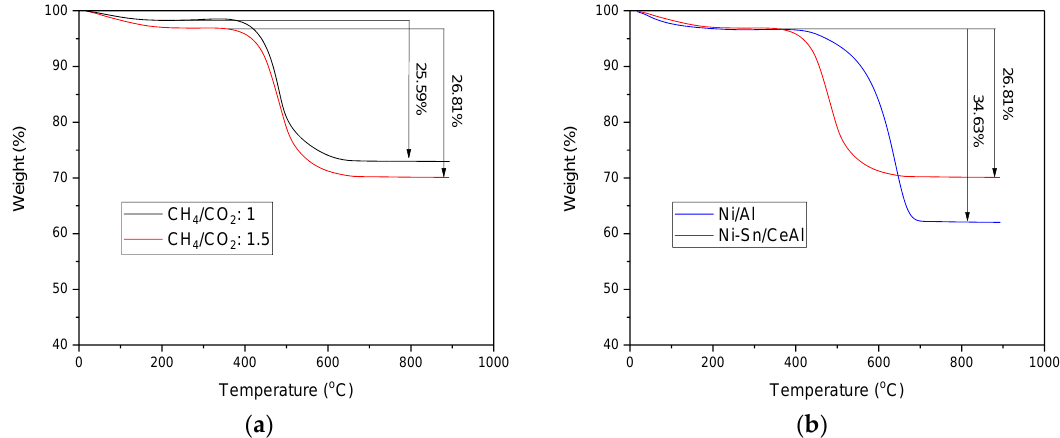
Figure 8. Thermogravimetric analysis for the catalysts after ( a ) Ni-Sn/CeAl at CH 4 /CO 2 molar ratios of 1 (model biogas) and 1.5 (sewage waste) and ( b ) Ni-Sn/CeAl and Ni/Al catalyst using CH 4 /CO 2 molar ratios of 1.5.